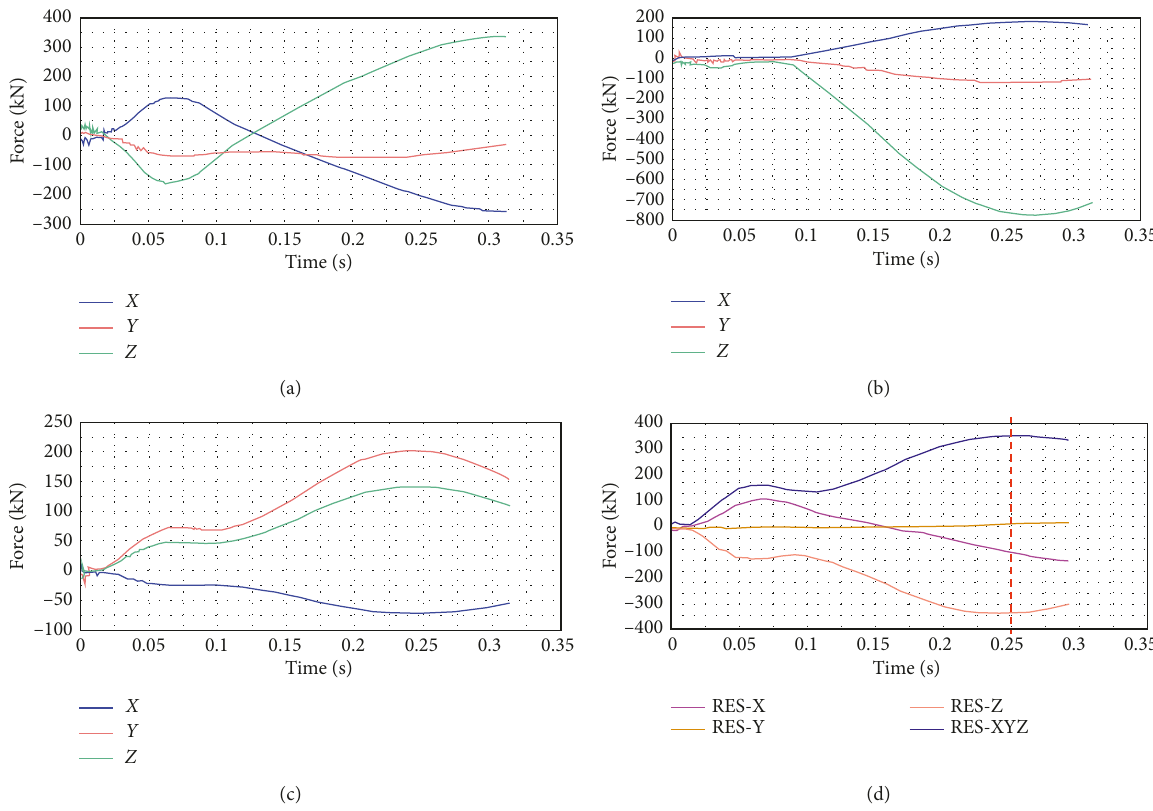
Figure 32: Reaction forces of full-FE model. (a) Node 52. (b) Node 55. (c) Node 66. (d) Resultant Forces.